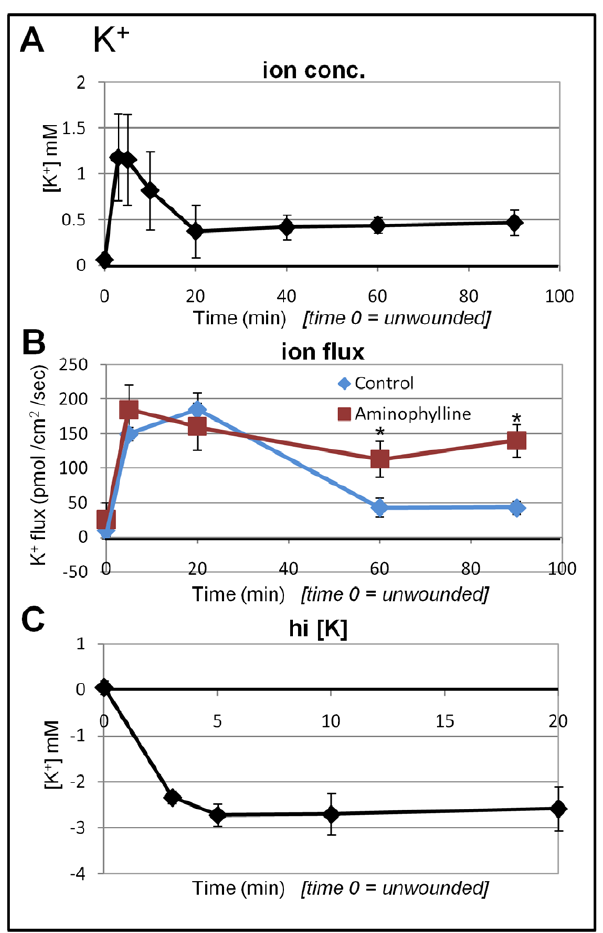
Figure 4. Potassium flux at corneal wounds. A. K + concentra- tion. Immediately after wounding there was a rapid transient increase of K + concentration. This initial high concentration decreased over 5–20 min after wounding, reaching a stable lower value. B. K + flux. There was a large K + efflux immediately after wounding, which dropped after 20 min. Aminophylline had no effect on the initial peak of efflux, but appeared to enhance efflux at later time points (60–90 min; *P , 0.03). C. K + concentration in high [K + ] . In hi-K + solution (20 mM) the initial peak of K + concentration was absent and the wound showed a lower K + concentration (negative values), indicating K +